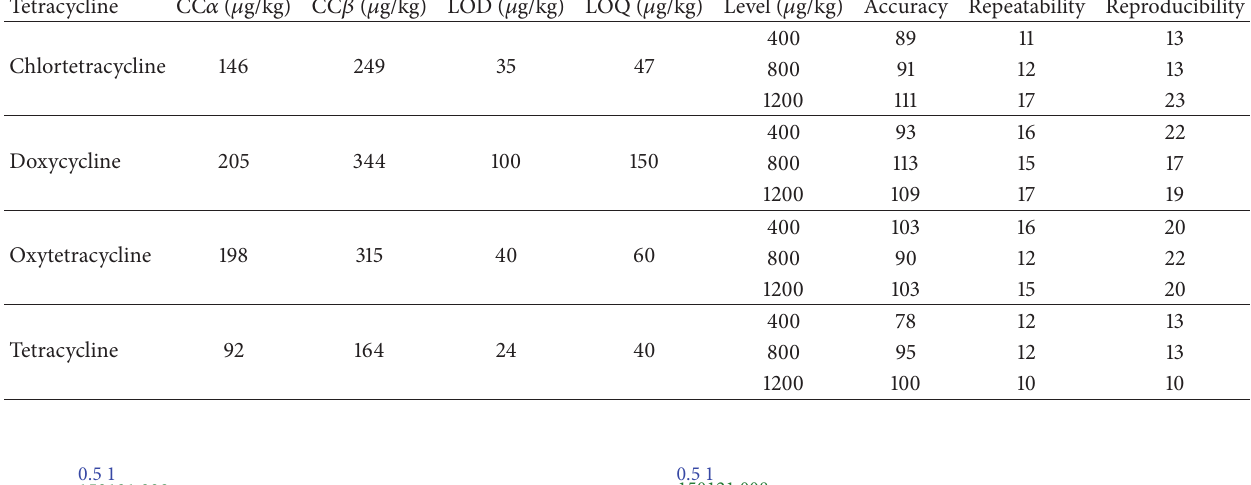
Table 2: Recoveries (%), repeatability (CV%), within-laboratory reproducibility (CV%), CC 𝛼 , CC 𝛽 , LOD, and LOQ of tetracyclines.